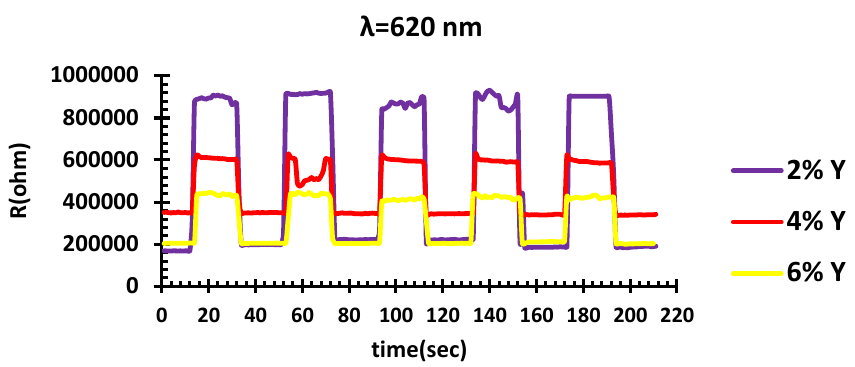
Fig. 7: Photo response time of the prepared undoped and doped Co sensor upon exposure to 470 nm light.